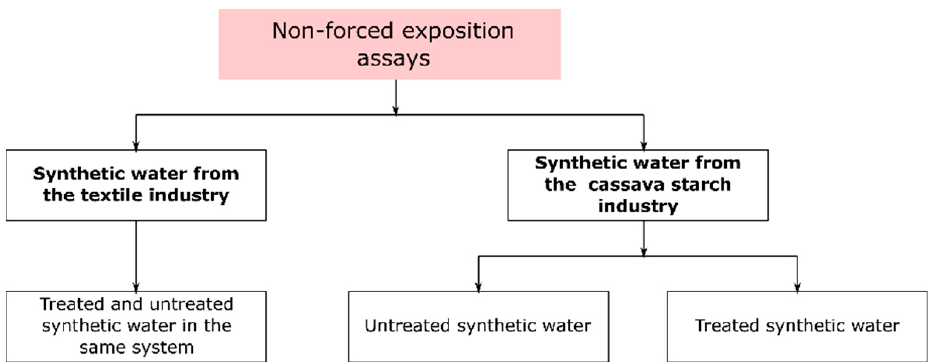
Figure 1. Summary of the non-forced exposition assays carried out to assess the quality of un- treated/treated synthetic waters from the textile and cassava starch industries.